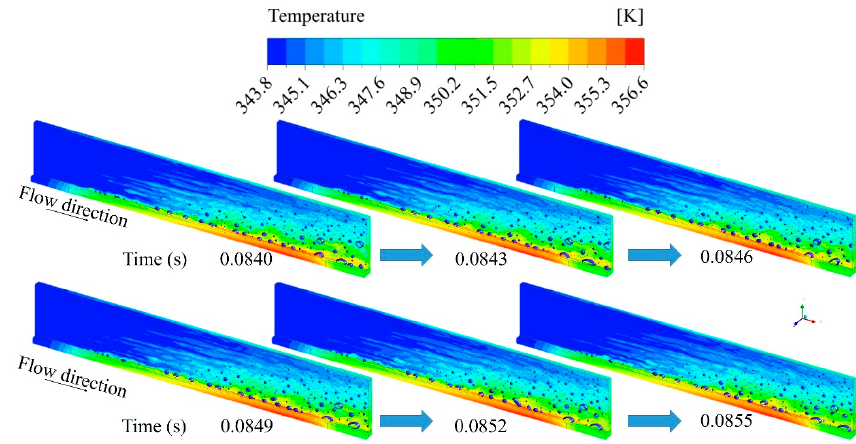
Figure 11. Transient temperature distribution and two-phase flow pattern at G = 700 kg/(m 2 ·s) for the cross-section of 0.2 × 0.5 mm.